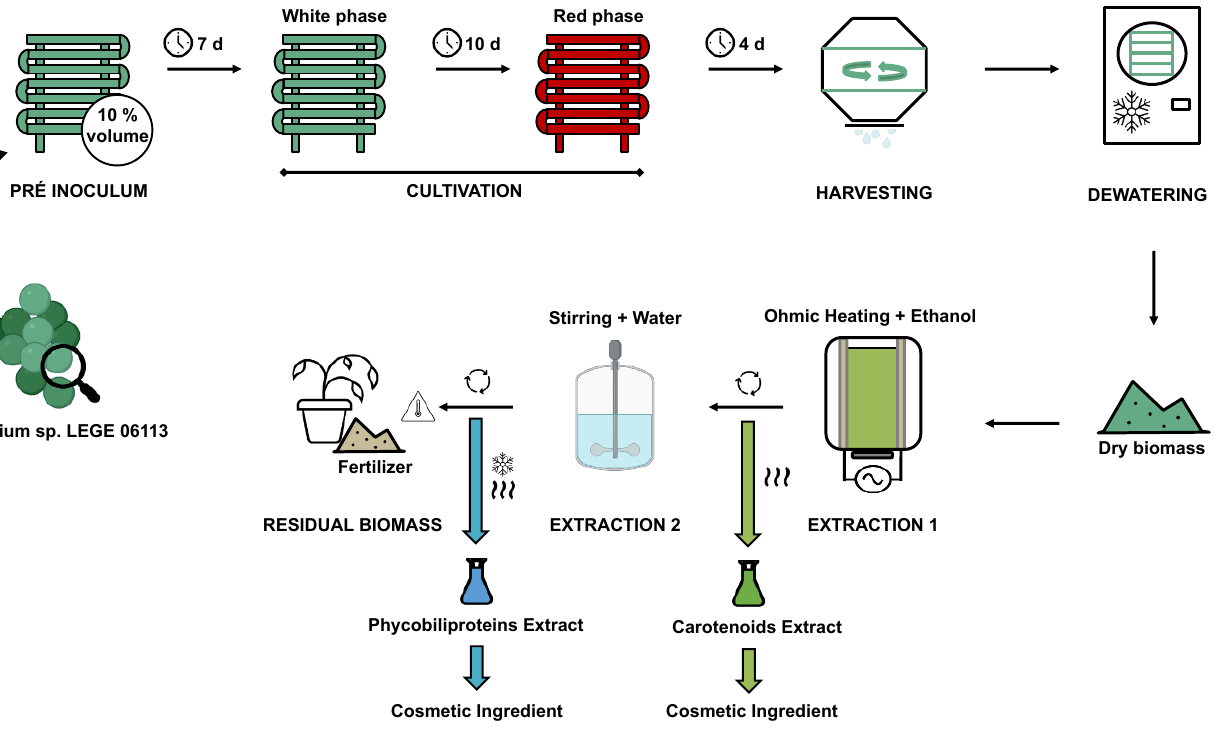
Figure 3. Final proposed model for Cyanobium sp. bioprocess.